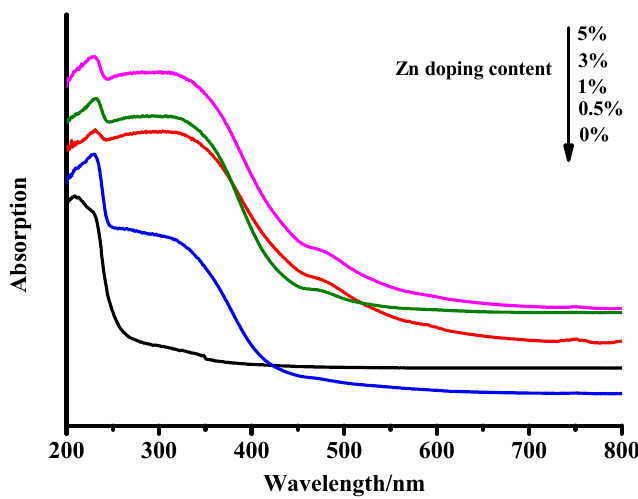
Figure 7. The UV-vis DRS spectra of the ZrO 2 and Zn–ZrO 2 NPs.